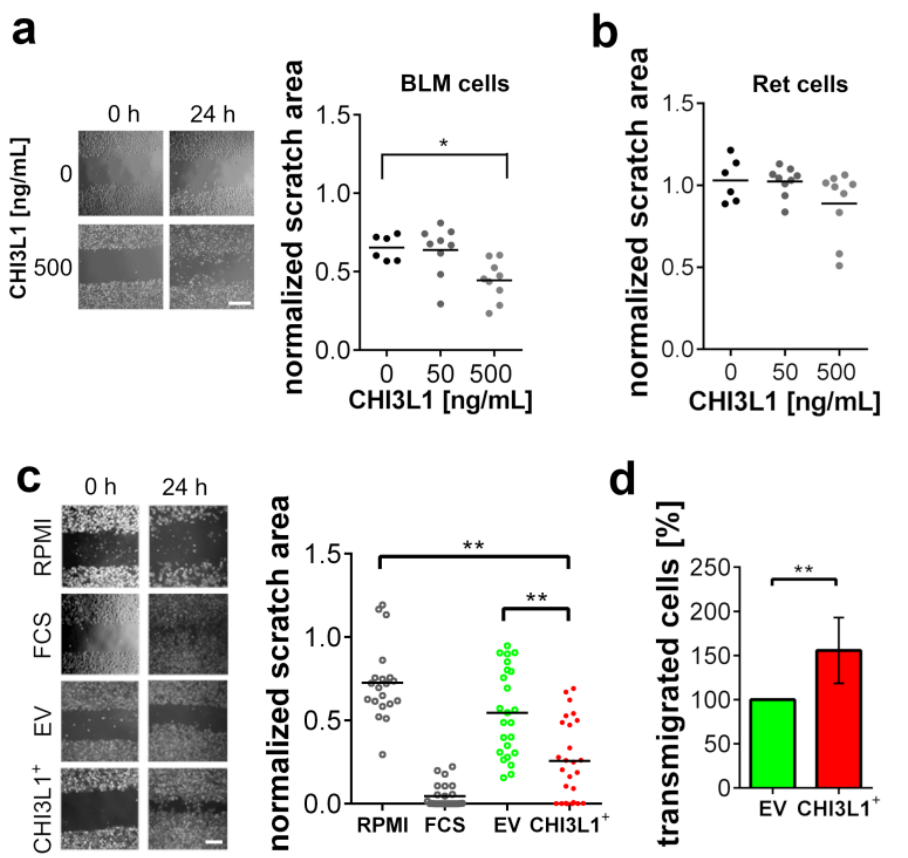
Figure 3. CHI3L1 promoted the migration of BLM cells and altered their secretome. ( a ) Representative bright-field microscopic images of the performed scratch assays with BLM cells. Treatment of BLM cells with 50 or 500 ng/mL CHI3L1 for 24 h. Scale bar = 100 µ m. n ≥ 6; * = p ≤ 0.05 one-way ANOVA. ( b ) Treatment of Ret cells with 50 and 500 ng/mL CHI3L1 ( c ) Scratch assay with Ret